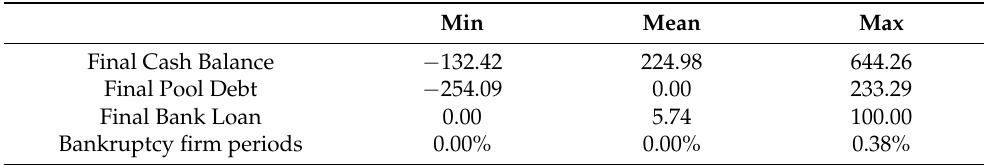
Table 8. Results for the base case with cooperation and interest rate difference (0.50%-0.50%-1.00%) (Correlation = 0.40).